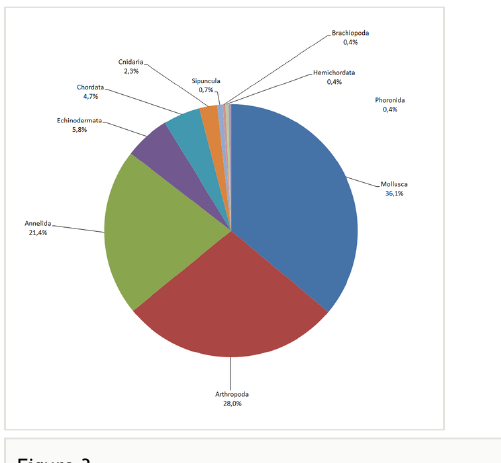
Figure 3. Percentage of macrofaunal species per phylum.